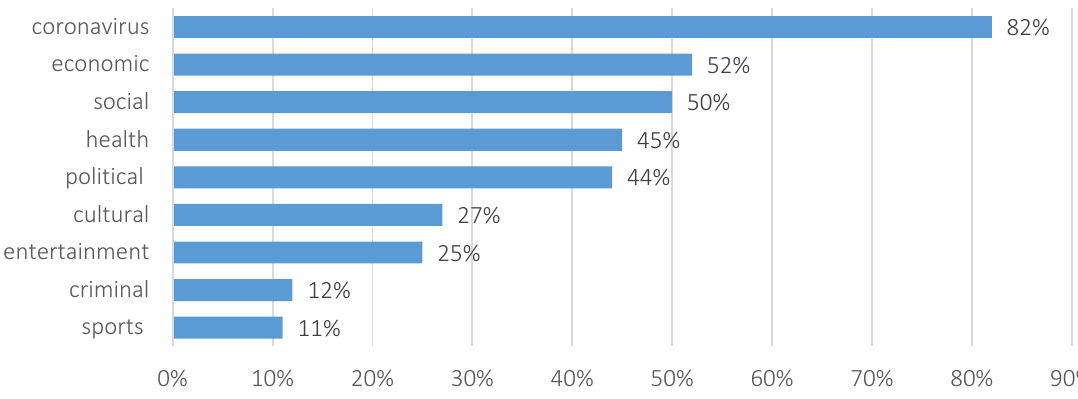
Figure 3. Topics of news read by respondents during the СOVID-19 pandemic